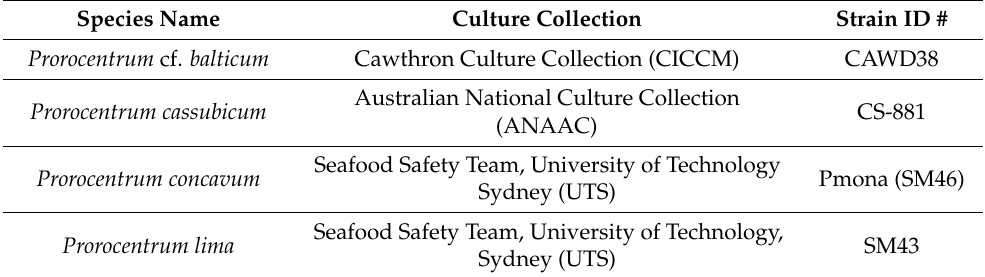
Table 4. All species used as negative controls for specificity testing of the P. minimum qPCR assay. Species names and which culture collection they can be found are listed, as well as the strain